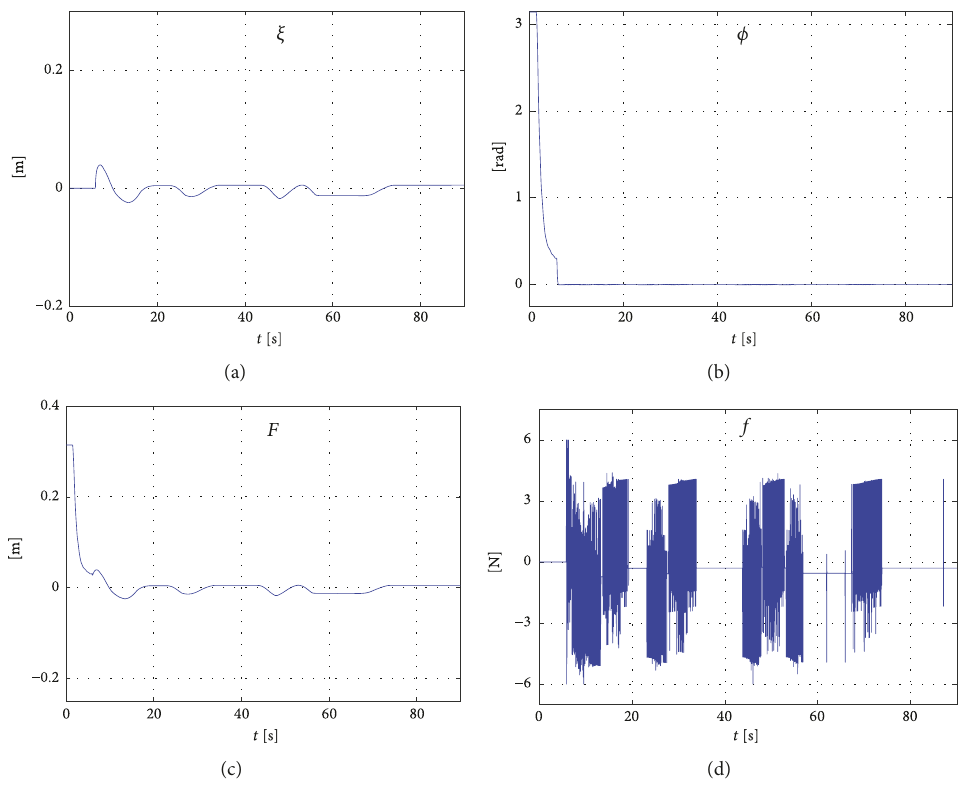
Figure 15: Experimental results when gains (42) are implemented without previously performing an experiment in the